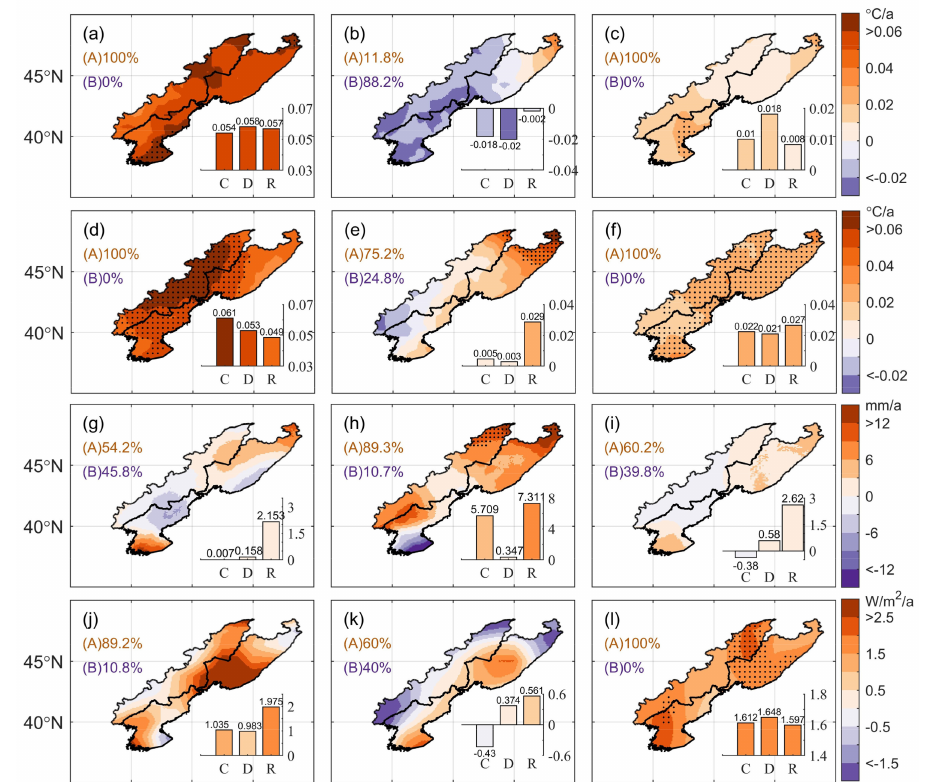
Figure 6. Spatial distribution of trend in Tmax, Tmin, precipitation and solar radiation in the China– DPRK–Russia cross-border area. ( a ) Trend in Tmax from 1982 to 1998. ( b ) Trend in Tmax from 1998 to 2015. ( c ) Trend in Tmax from 1982 to 2015. ( d ) Trend in Tmin from 1982 to 1998. ( e ) Trend in Tmin from 1998 to 2015. ( f ) Trend in Tmin from 1982 to 2015. ( g ) Trend in precipitation from 1982 to 1998. ( h ) Trend in precipitation from 1998 to 2015. ( i ) Trend in precipitation from 1982 to 2015. ( j ) Trend in solar radiation from 1982 to 1998. ( k ) Trend in solar radiation from 1998 to 2015. ( l ) Trend in solar radiation from 1982 to 2015. The region with dots represents the sites with significant trend ( p <